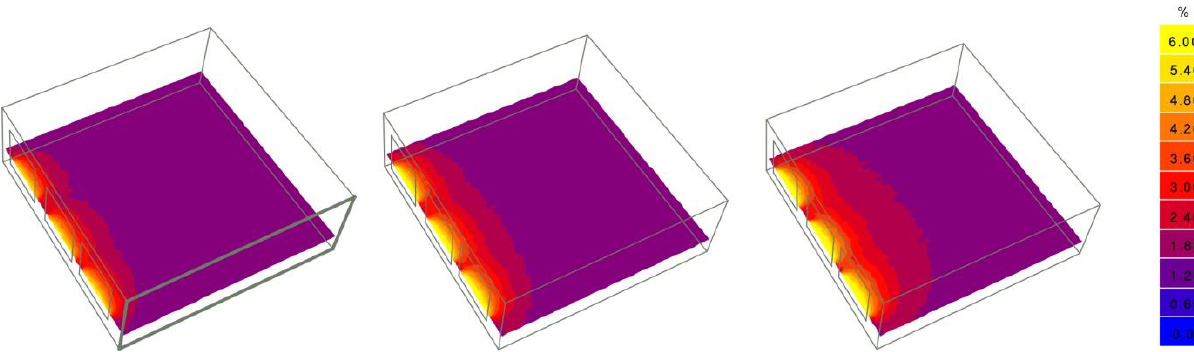
Figure 3. Daylight factor in an office space on a 15 m, 30 m and 100 m wide